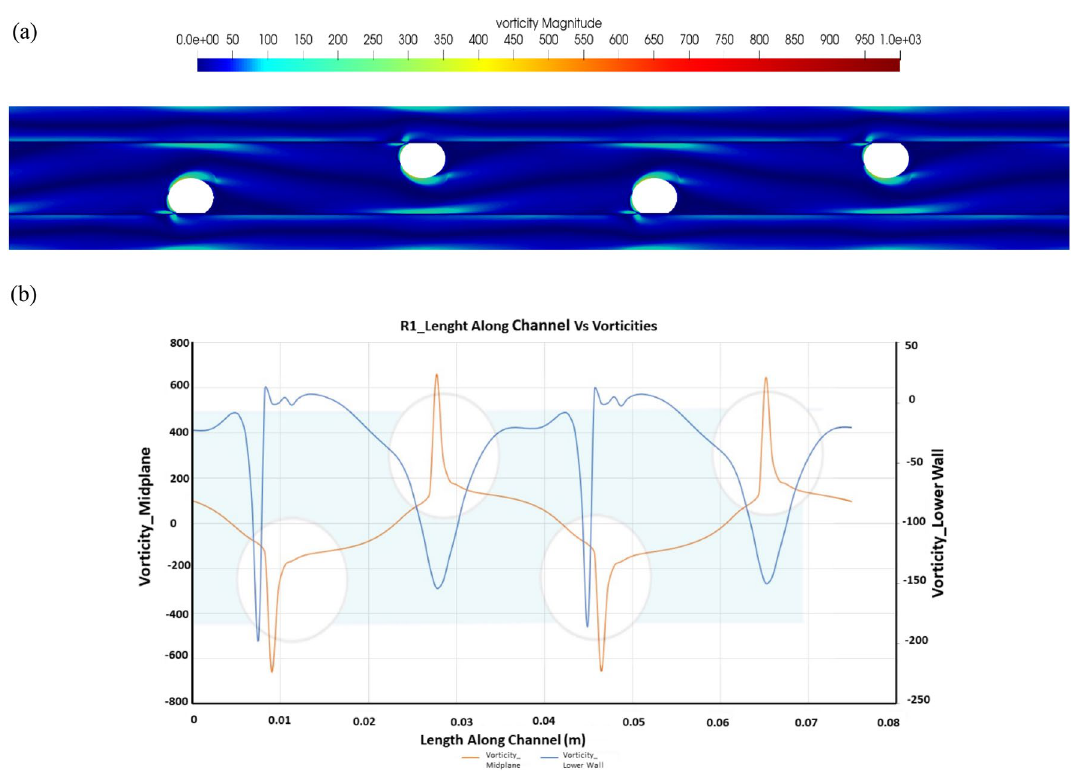
Figure 4. Vorticity plot for R1 ( a ) vorticity distribution along the channel and ( b ) center line vorticity vs. vorticity along the lower wall of the channel.